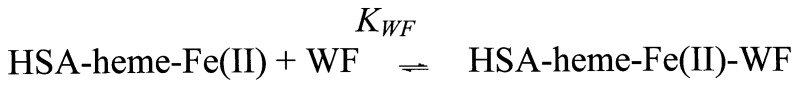
Scheme for the WF equilibrium binding to HSA-heme-Fe(II).